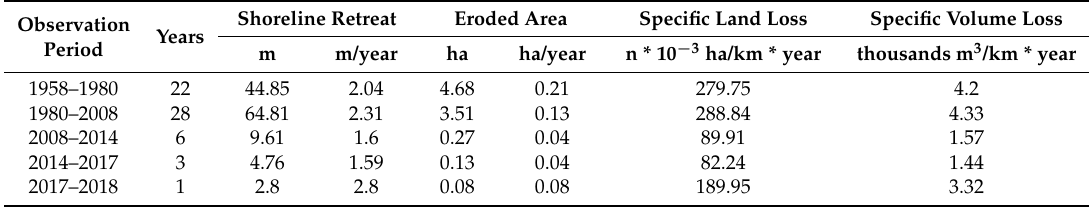
Table 5. Detailed morphometric indicators from different observation periods for Sector